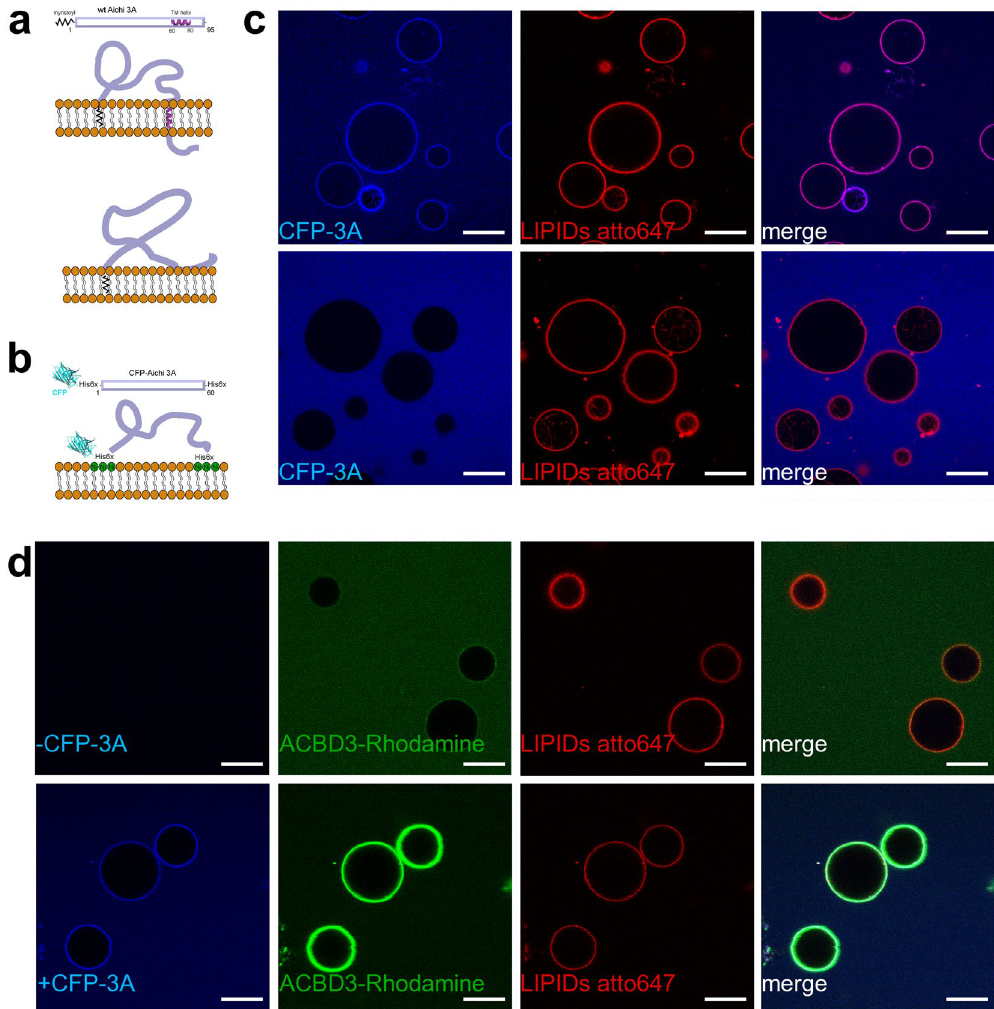
Figure 1. Aichi virus 3A protein on the membrane. ( A ) Schematic representation of the wild type 3A protein. The two possible topologies of the wild type 3A protein are shown. Upper panel – the C-terminal hydrophobic stretch is depicted as a transmembrane helix. Lower panel – the C-terminal hydrophobic stretch is depicted as semi-buried in the lipid bilayer. ( B ) Schematic representation of the mCerulean - 3A fusion protein (named CFP-3A). CFP-3A contains two 6xHis tags; one between the CFP and its N-terminus and one at the C-terminus. These two His tags can be used to attach the CFP-3A protein to a membrane containing DGS-NTA(Ni) (a lipid that has Ni 2 + bound to its headgroup). ( C ) CFP-3A bound to GUVs. Upper panel: 250 nM CFP-3A was added to GUVs containing 5% of DGS-NTA(Ni) and ATTO647N-DOPE (0.1 mol %). Lower panel: as above but DGS- NTA(Ni) was replaced by POPC. The CFP-3A signal is in blue and the ATTO647 signal in red. Representative image of three independent experiments. Scale bar = 20 µ m. ( D ) Aichi virus 3A protein efficiently recruits ACBD3 to the membrane. Rhodamine labeled ACBD3 (250 nM) was incubated with GUVs without 3A protein (upper panel) or with 3A protein (250 nM, lower panel). The CFP-3A signal is in blue, the ACBD3- rhodamine signal is in green, and ATTO647 labeled lipids in in red. Representative image of three independent experiments. Scale bar = 20 µ